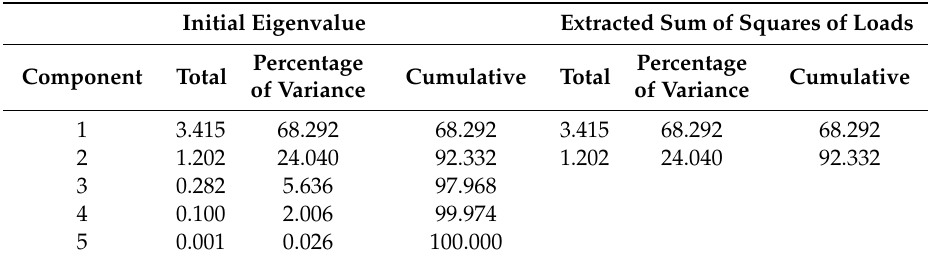
Table 3. The total variance interpretation of relevant antibiotic data in Chongqing, 2013.